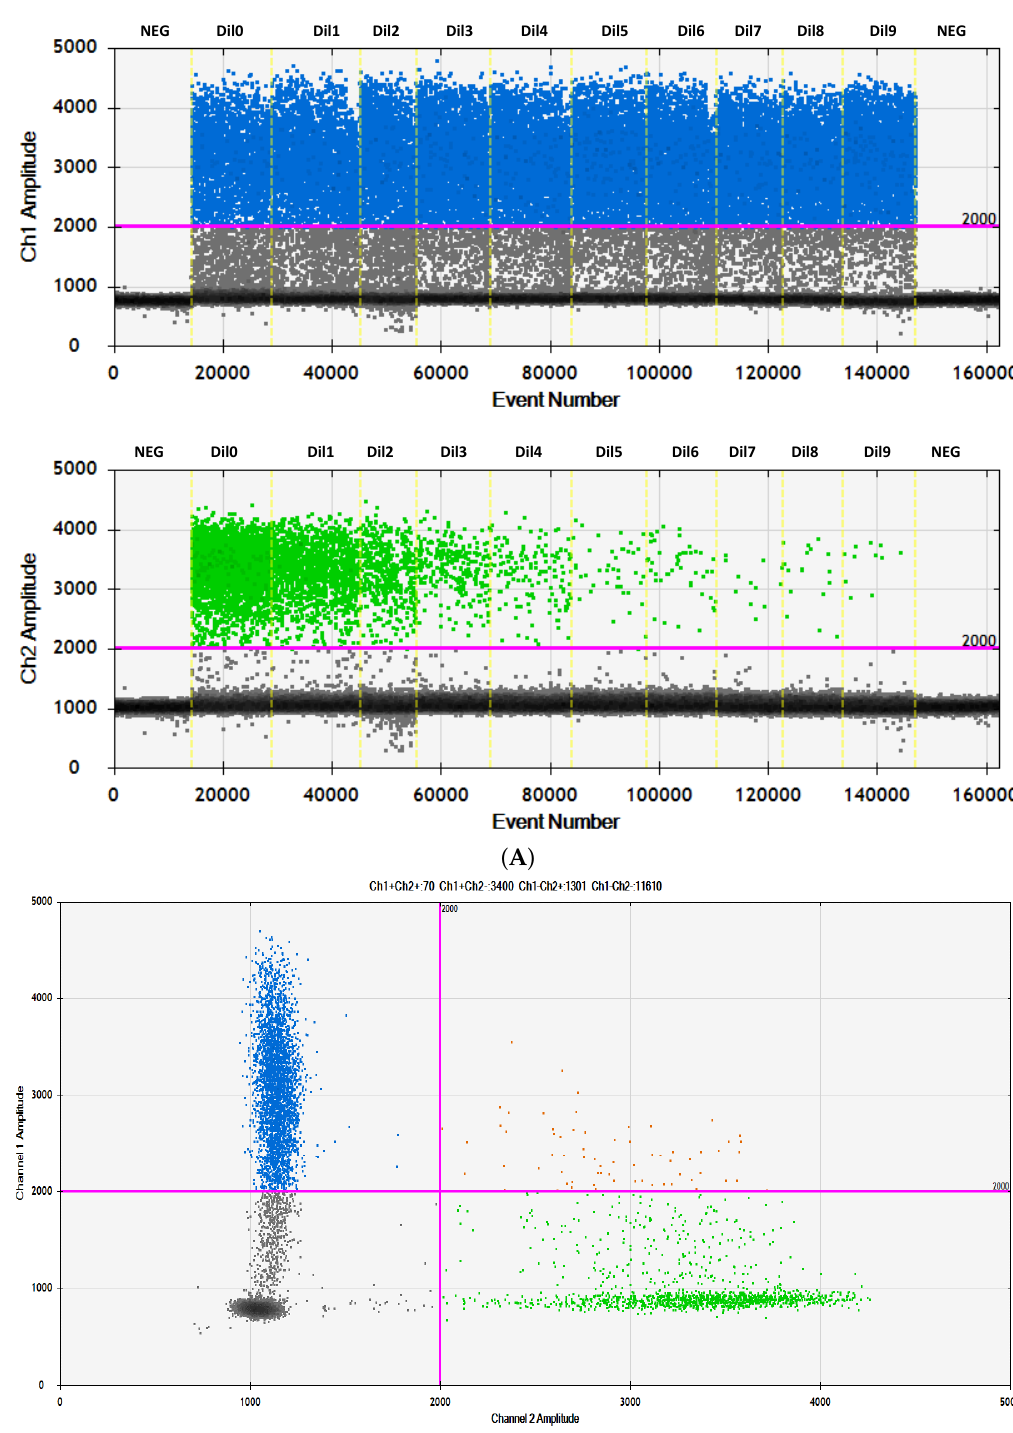
Figure 1. ( A ) 1D plot showing ddPCR amplification of serial dilutions of the HCC DNA sample 433 carrying the heterozy- gous mutation − 124A in TERTp as determined by Sanger sequencing in the background of TERTp wildtype DNA (NEG, No DNA; Dil0, 50%; Dil1, 25%; Dil2, 12.5%; Dil3, 6.25%; Dil4, 3.12%; Dil5, 1.56%; Dil6, 0.78%; Dil7, 0.39%; Dil8, 0.19%; Dil9, 0.095%). ( B ) 2D amplitude plots of the raw data are shown for ddPCR 25% − 124A/WT. Green: HEX probe for TERTp − 124A; blue: FAM probe for TERTp WT; orange: double positive droplets containing both TERTp − 124A and TERTp wildtype alleles ( − 124G); grey: droplets negative for template DNA. The pink line is a manually set